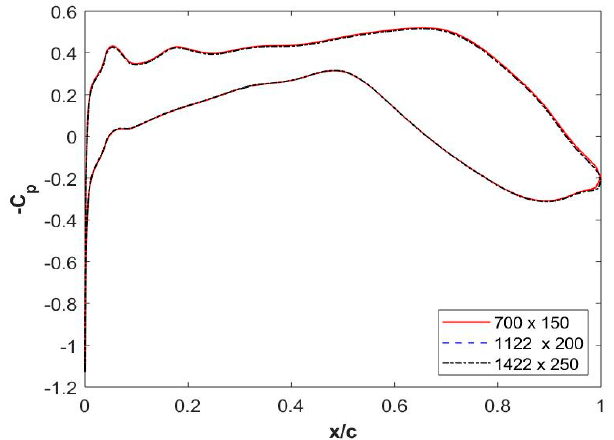
Figure 13. The sensitivity of grids on the computed surface coefficient of pressure.